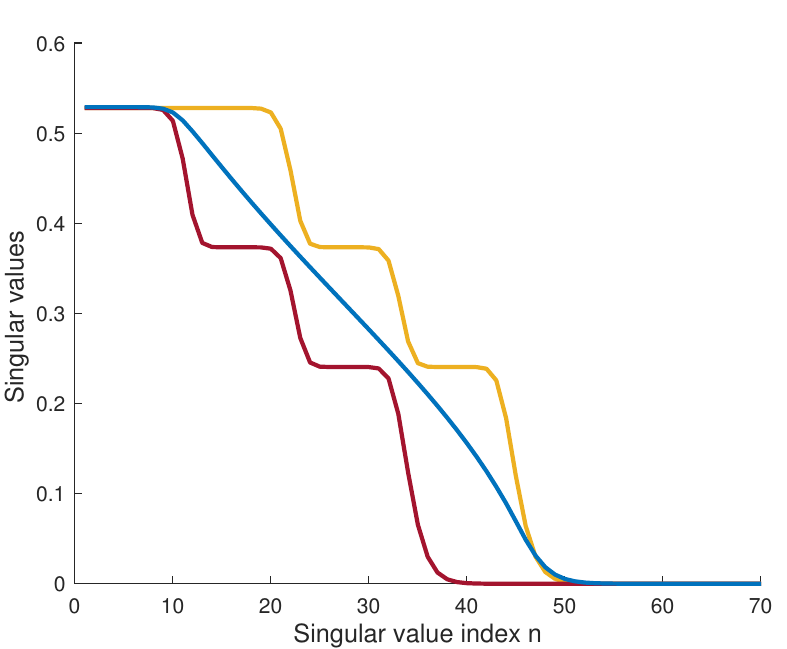
Figure 8. Singular values behaviour of A f for the case of continuous frequencies for M = 3. The other parameters are set as in Figure 7. Yellow and red lines represent the square root of the eigenvalues of (cid:101) A † f A f and (cid:98) A † f A f ,